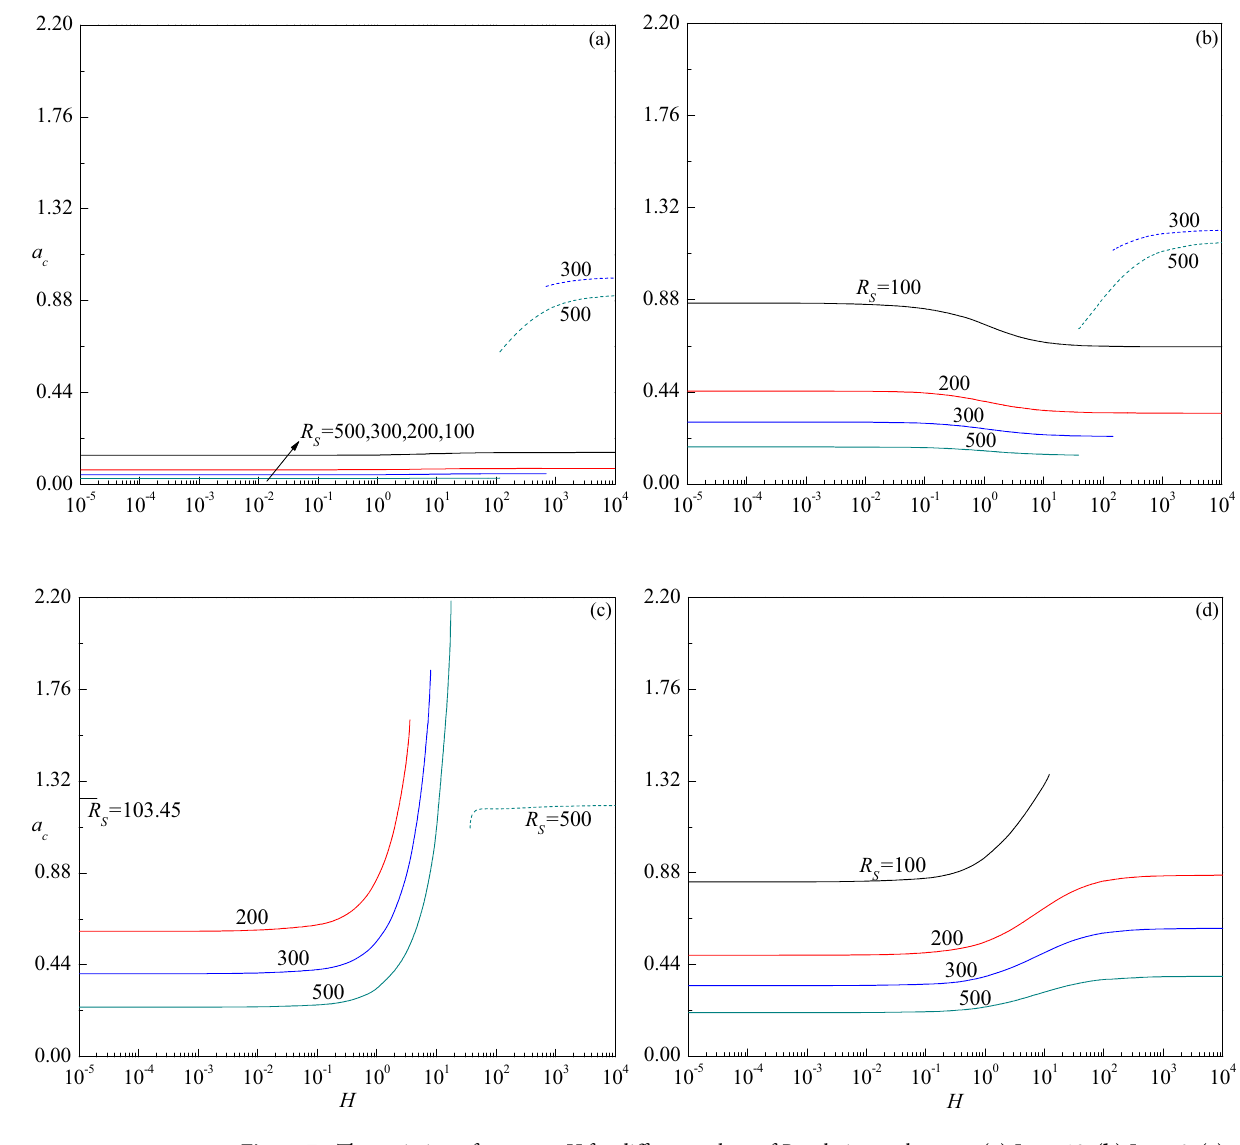
Figure 7. The variation of a c versus H for different values of R S relative to the cases ( a ) Le = 10 , ( b ) Le = 2 , ( c ) Le = 0.5 and ( d ) Le = 0.1 , when γ = 1 Figure 9a–d demonstrate the impact of porosity modified conductivities ratio γ on the variation of R Dc as a function of H for different values of R S . For γ = 0.01, it is observed that the instability sets in always via stationary mode throughout the range of H for the values of R S considered (Fig. 9d). However, depending on the value of R S , the shifting of instability from the stationary to the travelling-wave mode emerges after certain values of H for γ = 0.1 (Fig. 9c), 1 (Fig. 9b) and 10 (Fig. 9a). Despite the critical thermal Darcy–Rayleigh number assuming different values at extreme values of H → 0 and H → ∞ for smaller and moderate values of γ (Fig. 9b–d), it becomes independent of H at sufficiently large values of γ (Fig. 9a). This is because, ˜ R D = R D as γ → ∞ and this describes a fluid with an extremely high thermal conductivity. This explains why the temperature of the fluid is not influenced by that of the solid, while the temperature of the solid is locally coincident with that of the fluid. As a result, interphase convection is prevented at the pore level, but extremely efficient heat conduction in the fluid creates a perfect thermal link between the phases. Moreover, both R Dc and a c become independent of γ at lower values of H as the solid phase does not affect the onset criterion. On the other hand, R Dc and a c